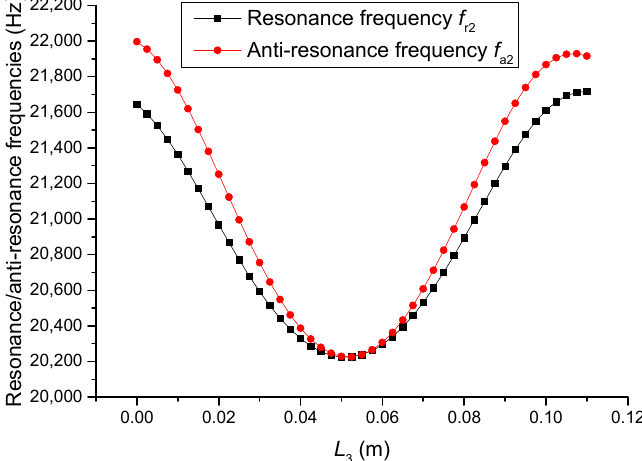
Figure 9. Theoretical relationships between the resonance/anti-resonance frequencies and length L 3 at the second mode (Position effect of PZT-2).